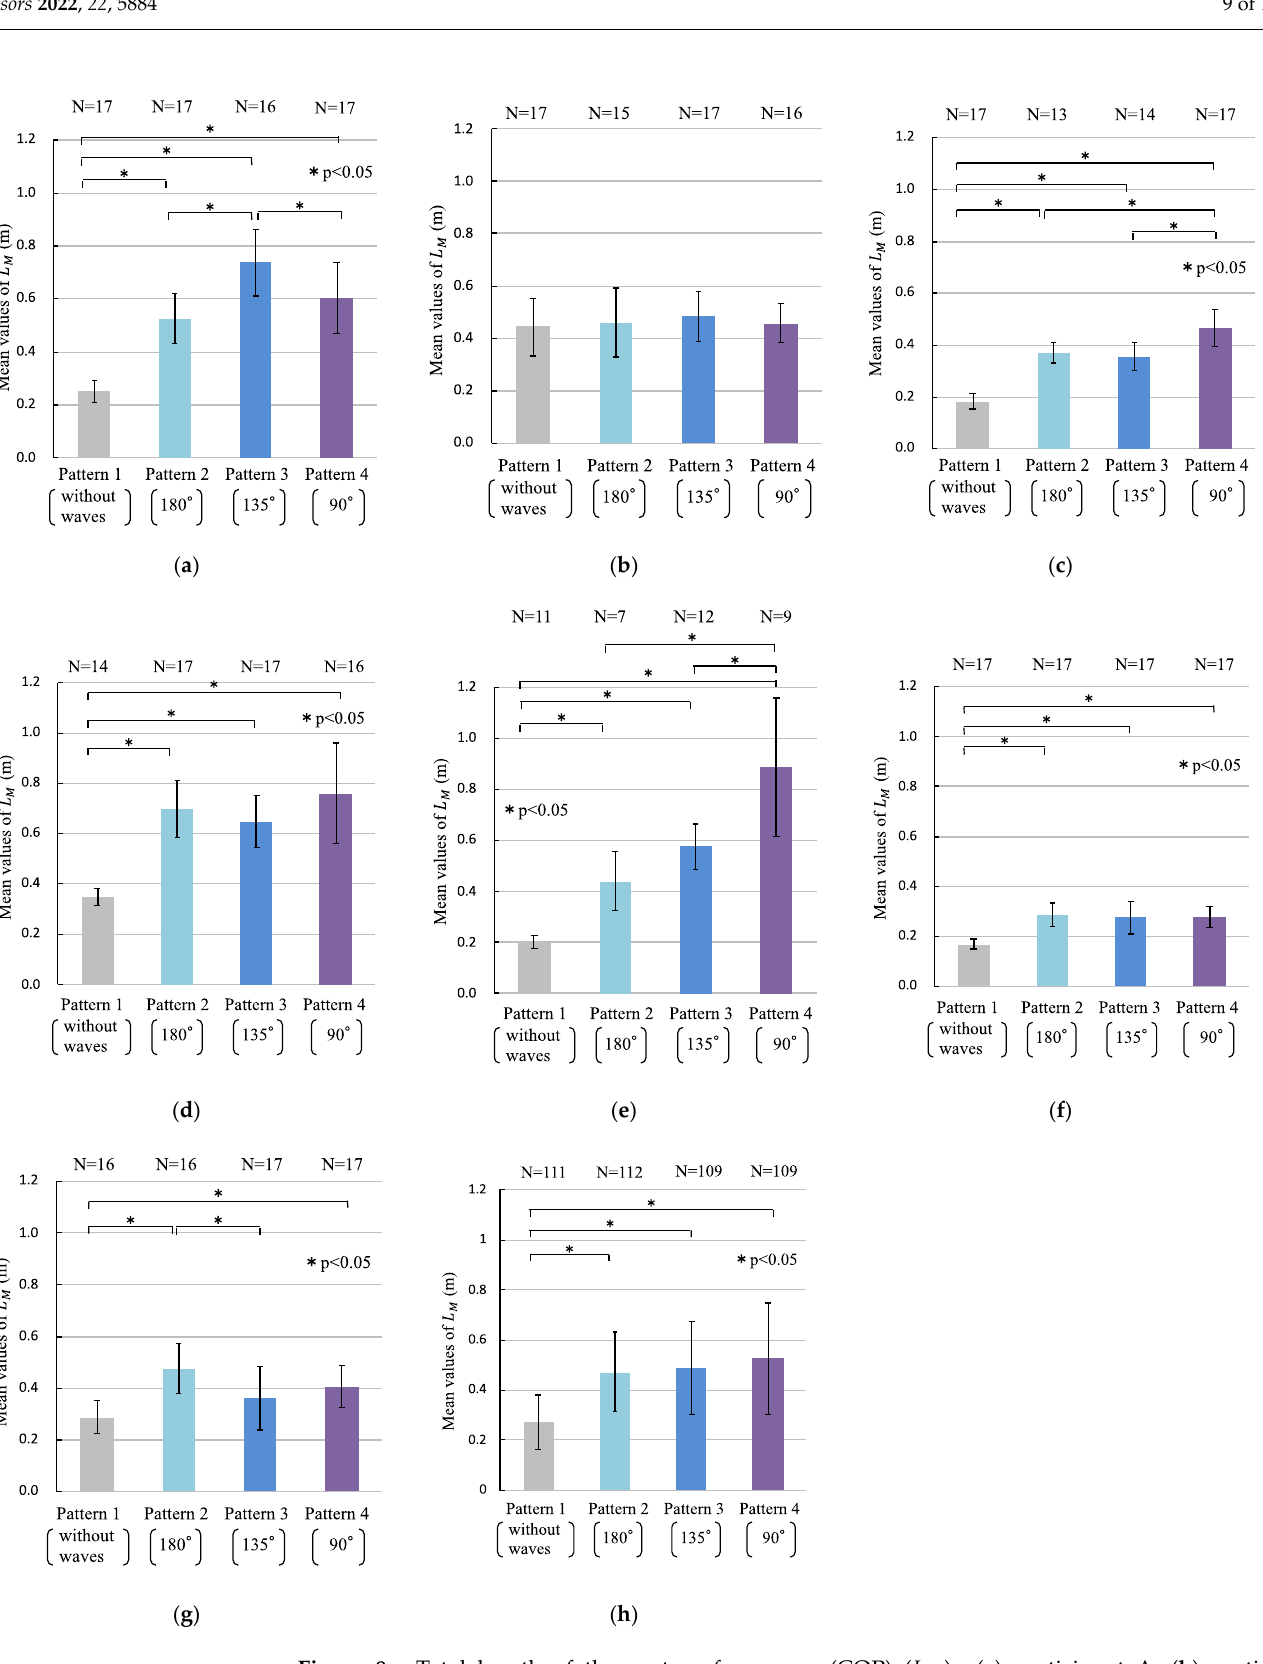
Figure 8. Total length of the center of pressure (COP) ( 𝐿 (cid:3014) ): ( a ) participant A; ( b ) participant B; ( c ) participant C; ( d ) participant D; ( e ) participant E; ( f ) participant F; ( g ) participant G; ( h ) all participants. 𝑁 is the number of valid 𝐿 (cid:3014) . The asterisk (*) indicates a significant difference (* p < 0.05).